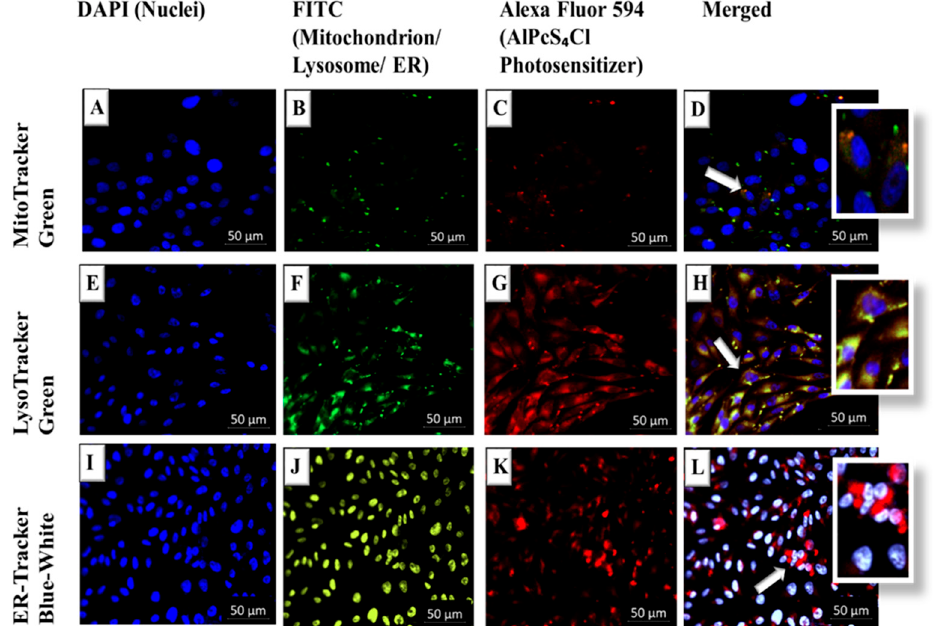
Figure 5. Live cell imaging of subcellular localization of AlPcS 4 Cl-AuNP-PS in A375 CSCs: ( A , E , I ) control stained blue with DAPI (nuclei); ( B , F , J ) mitochondrion/lysosome fluoresce green and ER fluoresces blue-white (FITC); ( C , G , K ) AlPcS 4 Cl-AuNP fluoresces red (A549); ( D ) In the superimposed images, merged channels are indicated with both green fluorescence from the mitochondrion and red fluorescence from the PS, resulting in intermediate yellow-orange; ( H ) in the superimposed images of merged channels, intermediate yellow-orange is visible, with green fluorescence from the mitochondrion and red fluorescence from the PS overlapping; ( L ) no overlapping is seen for the ER, which when merged with the PS fluoresces red. Arrows represent localization of PS in organelle.